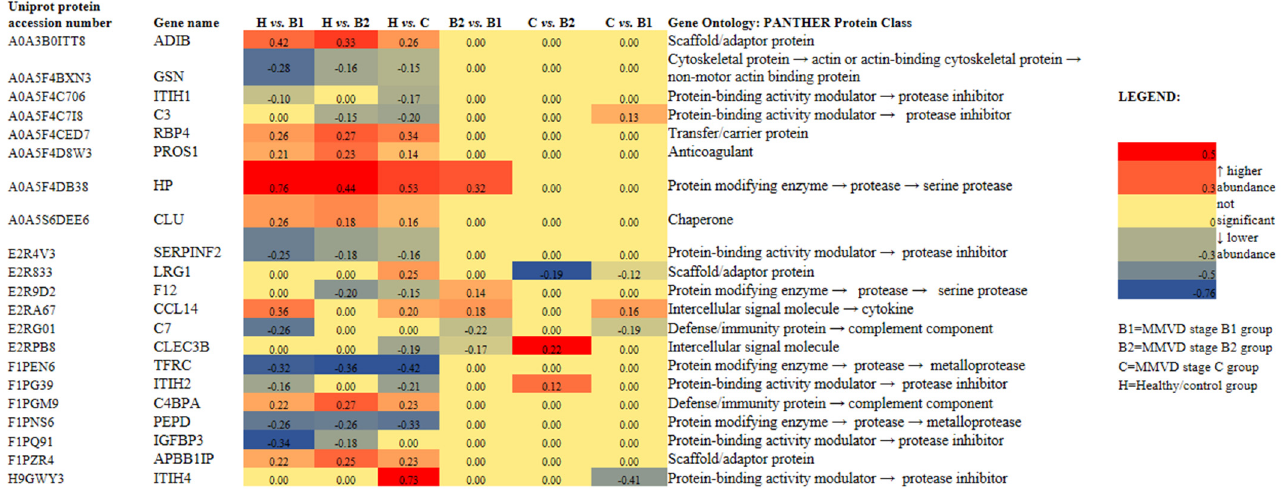
Figure 2. Heat map of 21 identified and quantified serum proteins with significantly different abun- dances ( p < 0.05, FDR < 0.05) in dogs diagnosed with different stages (B1 (N = 13), B2 (N = 12), and C (N = 13)) of naturally occurring myxomatous mitral valve disease (MMVD) and the healthy/control group (N = 12). N represents the number of serum samples (biological replicates). A heat map was created using the log2FC values (FC = fold change) calculated for master proteins after post-hoc analysis in R. Gene ontology analysis was performed in the PANTHER classification tool with Canis lupus familiaris as the selected organism. The heat map was created in Microsoft Excel. ADIB = adiponectin B; GSN = actin-depolymerizing factor/gelsolin; ITIH1 = inter-alpha-trypsin inhibitor heavy chain 1; C3 = anaphylatoxin-like domain-containing protein/complement C3; RBP4 = plasma retinol-binding protein; PROS1 = vitamin K-dependent protein S; HP = haptoglobin; CLU = clusterin, SERPINF2 = serpin family F member 2; LRG1 = leucine-rich alpha-2-glycoprotein 1; F12 = coagulation factor XII; CCL14 = C-C motif chemokine; C7 = complement C7; CLEC3B = C-type lectin domain family 3 member B/tetranectin; TFRC = transferrin receptor protein 1; ITIH2 = inter- alpha-trypsin inhibitor heavy chain 2; C4BPA = complement component 4 binding protein alpha; PEPD = peptidase D; IGFBP3 = insulin-like growth factor binding protein 3; APBB1P = amyloid beta precursor protein binding family B member 1; ITIH4 = inter-alpha-trypsin inhibitor heavy chain